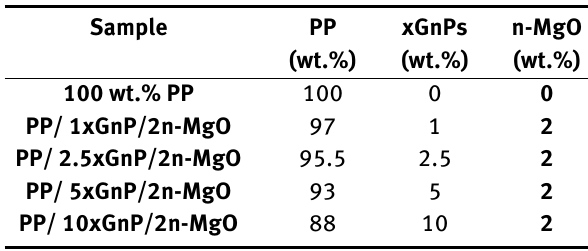
Table 1: Composition of composites. Sample PP